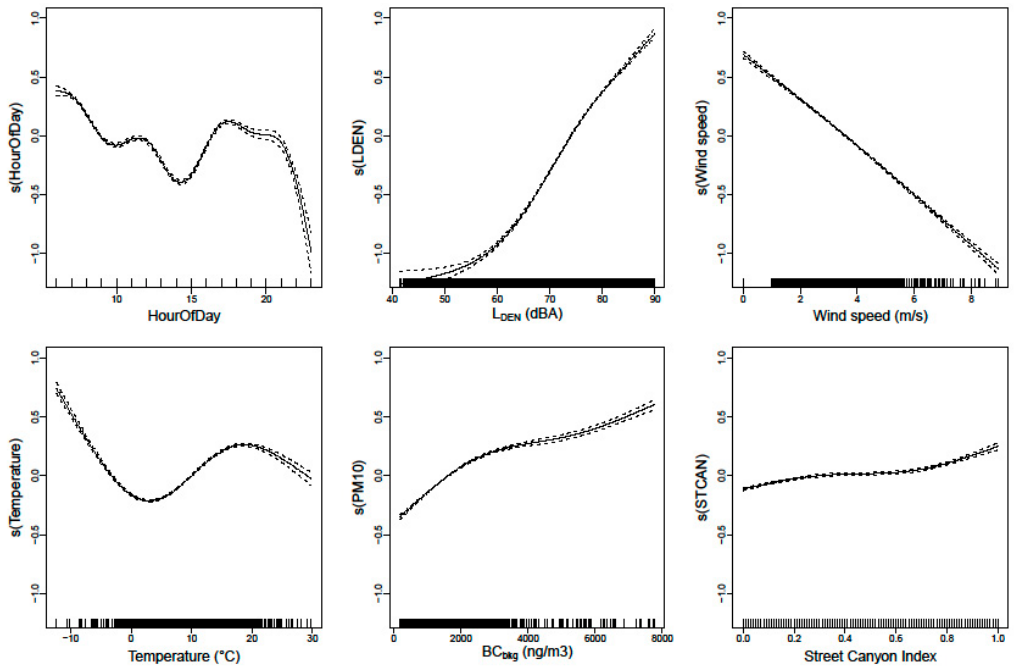
Figure 5. Splines of the gam model for the six covariates; the diurnal pattern in the Hour of Day covariate, the diurnal patterns of meteorological aspects in particulate matter dispersion and coagulation, and the dynamics of the engine emission as a function of the changing traffic dynamics over de diurnal pattern.